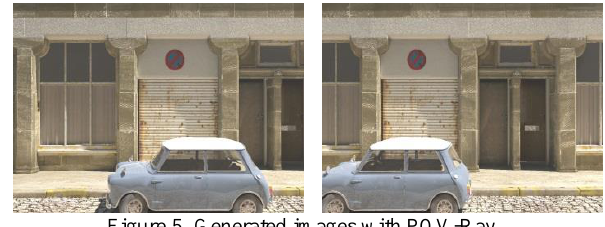
Figure 5. Generated images with POV-Ray.